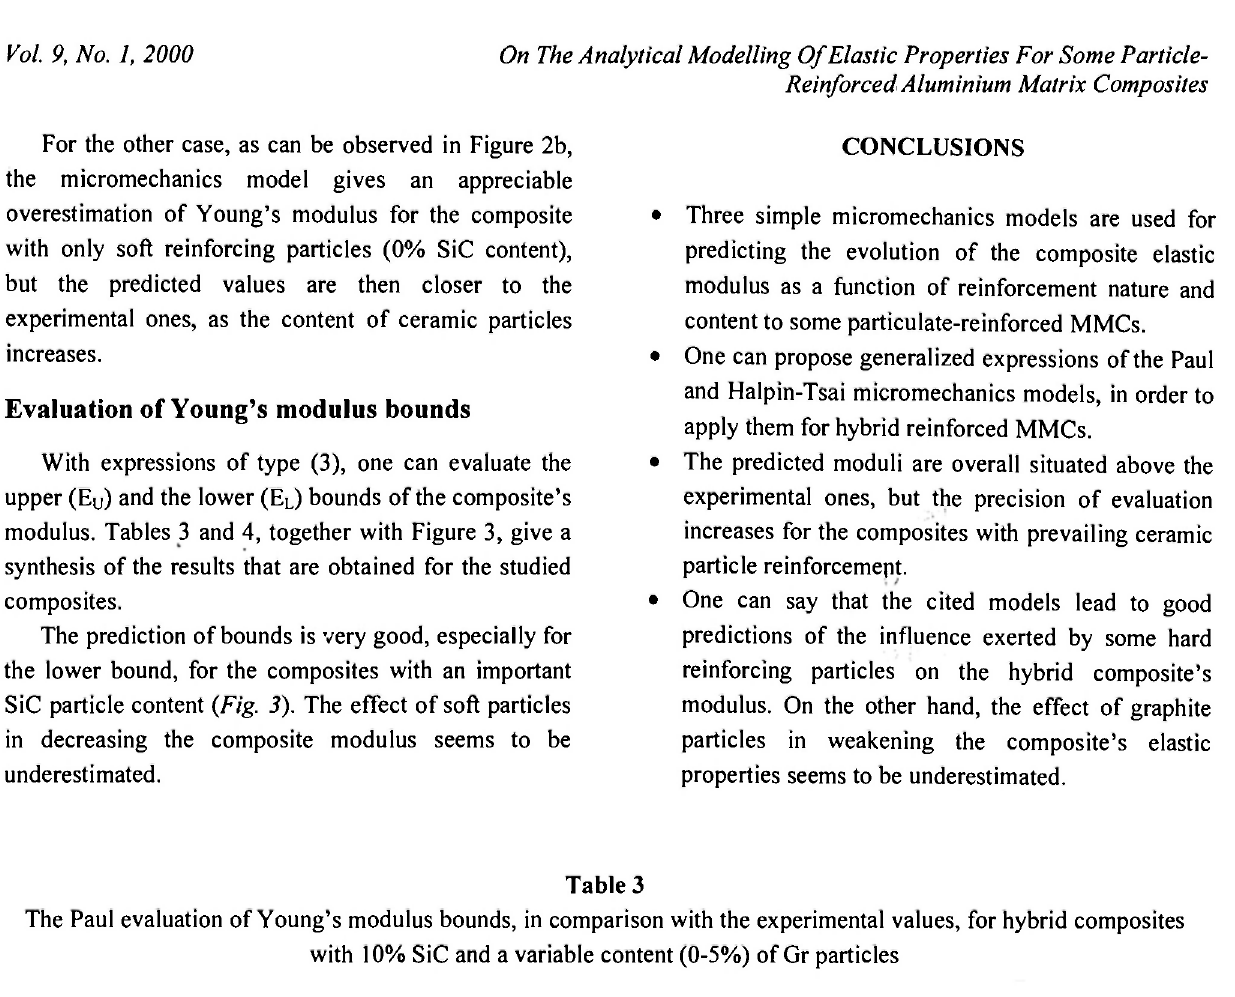
The Paul evaluation of Young's modulus bounds, in comparison with the experimental values, for hybrid composites with 5% Gr and a variable content (0-9%) of SiC